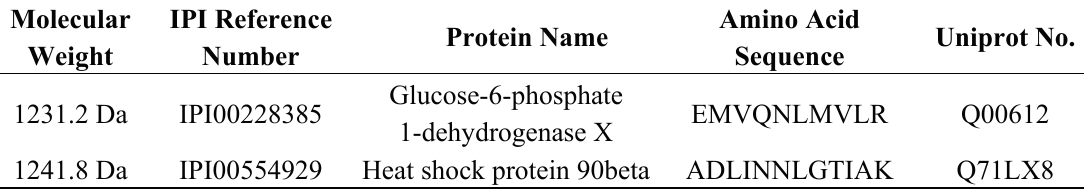
Table 4. Identified peptides.